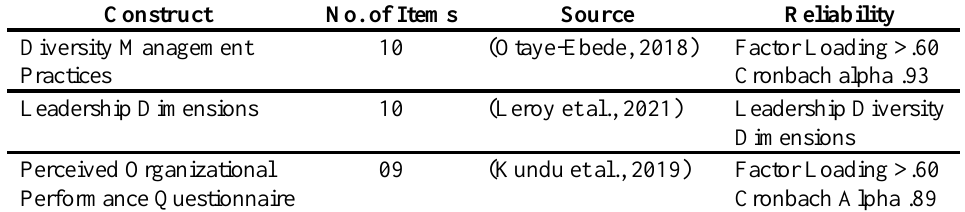
Table.1. Validity of Instrument for Measurement Scales for the